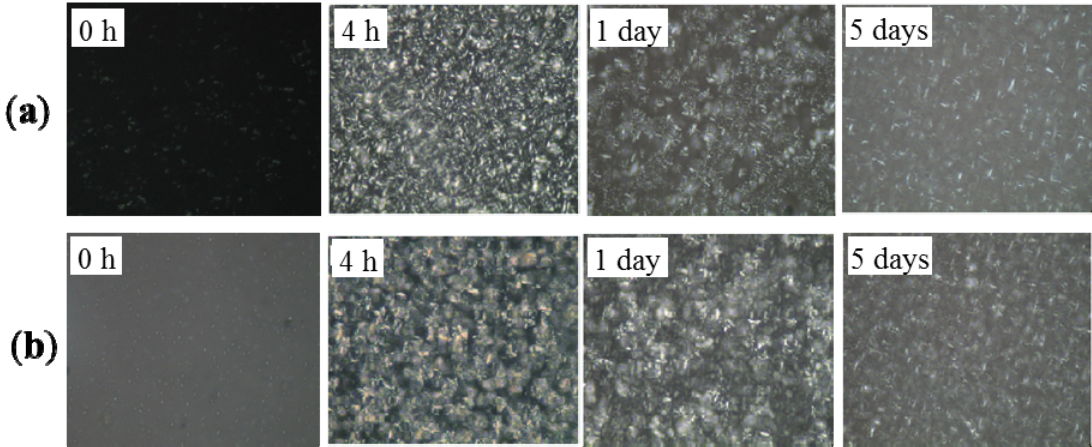
Figure 2. Polarized light photomicrographs for the PS/PO oil blends under 60 MPa HPM treatment: ( a ) Treated once and crystallized 0 h, 4 h, 1 day and 5 days. ( b ) Treated twice and crystallized 0 h, 4 h, 1 day and 5 days respectively. Magnification 500×.